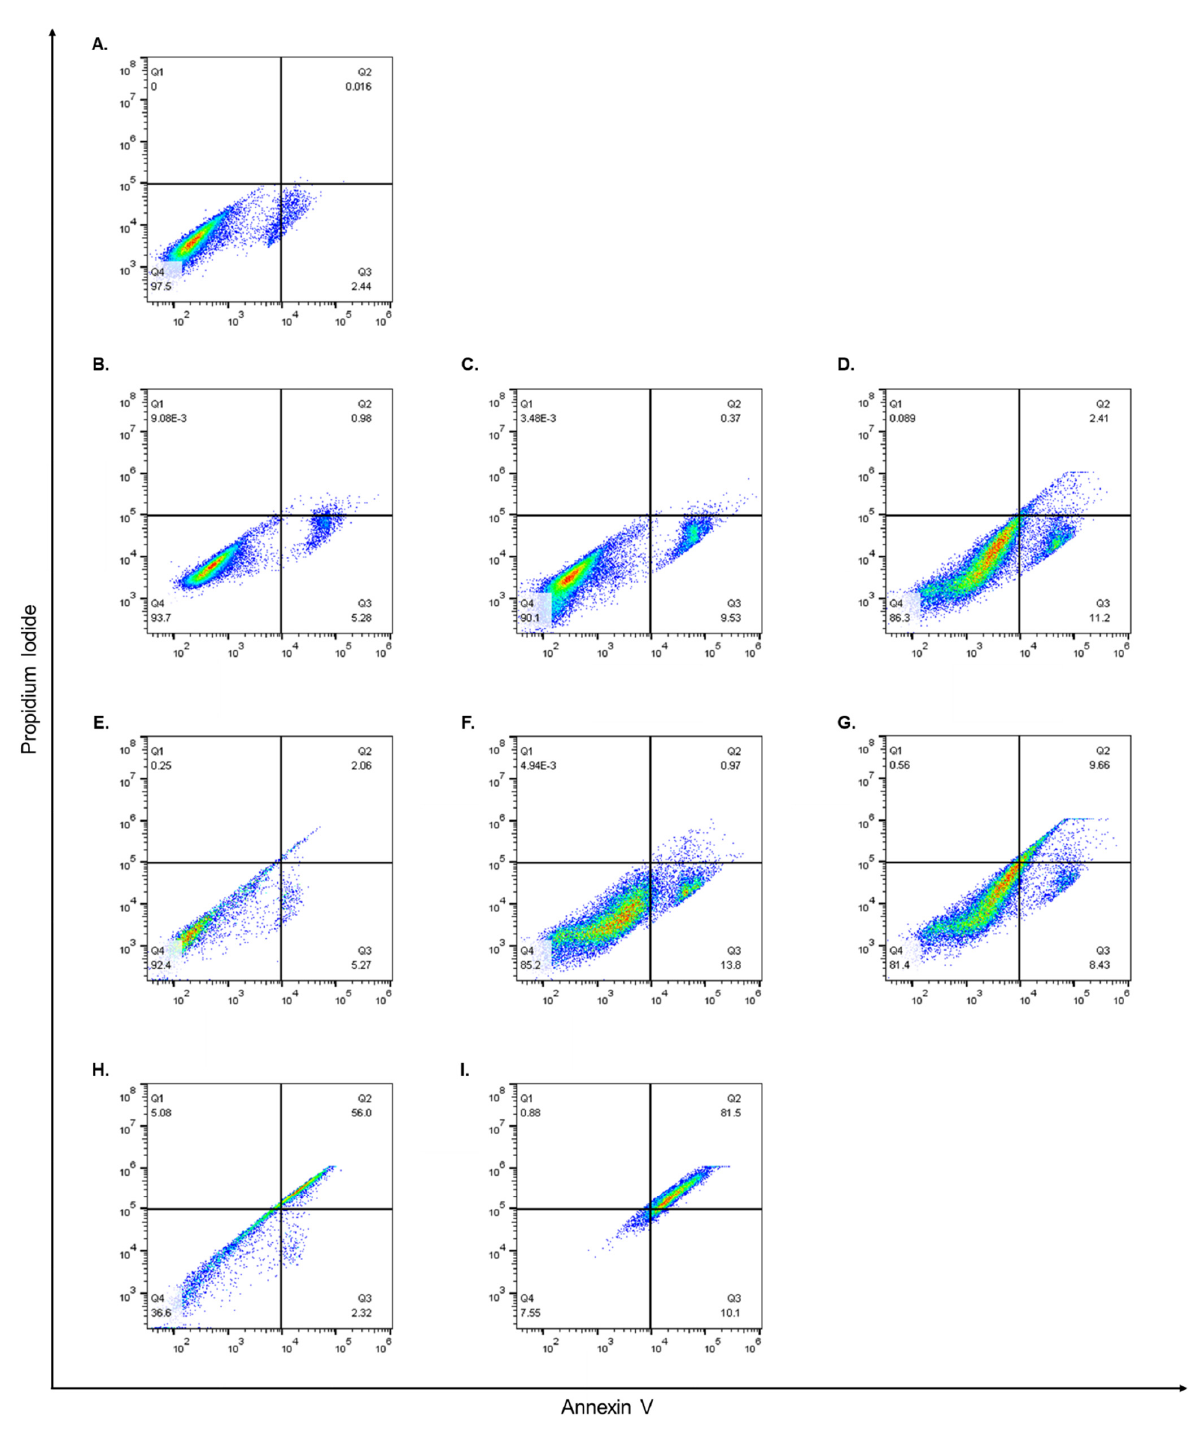
Figure 6. Apoptotic effects of free and encapsulated AA and OX. MCF-7 cells were treated for 48 h with CS NPs ( A ) or the IC 50 concentrations of AA ( B ), AA/CS NPs ( C ), AA/PEG-CS NPs ( D ), OX ( E ), OX/CS NPs ( F ), OX/PEG-CS NPs ( G ), AA-OX/CS NPs ( H ) or AA-OX/PEG-CS NPs ( I ). Thereafter, the percentages of viable, early, and late apoptotic cells were detected via Annexin/PI staining that was measured by the flow cytometry analysis, as described in Section 2.2.7. The experiment has been conducted in